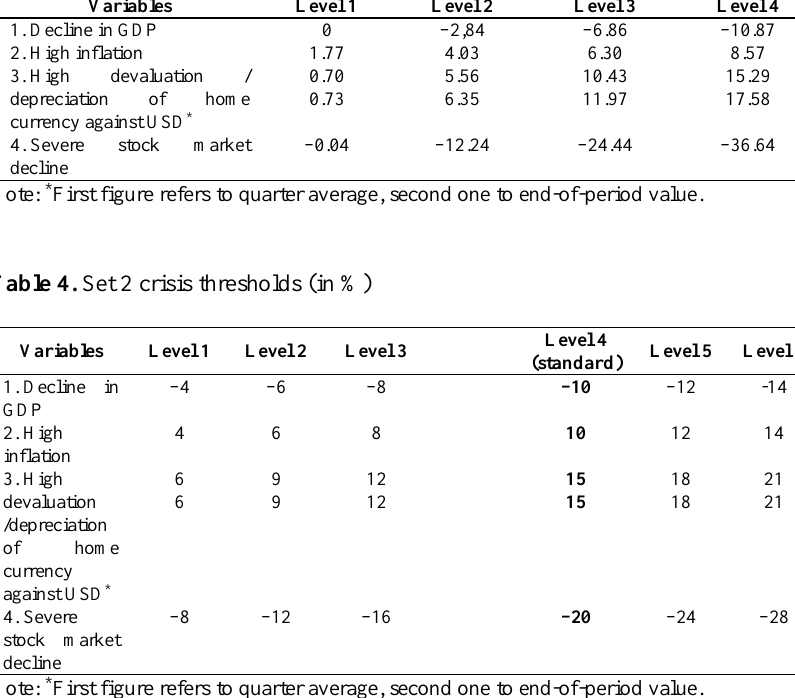
Table 5. Signs of statistically significant parameters for different threshold